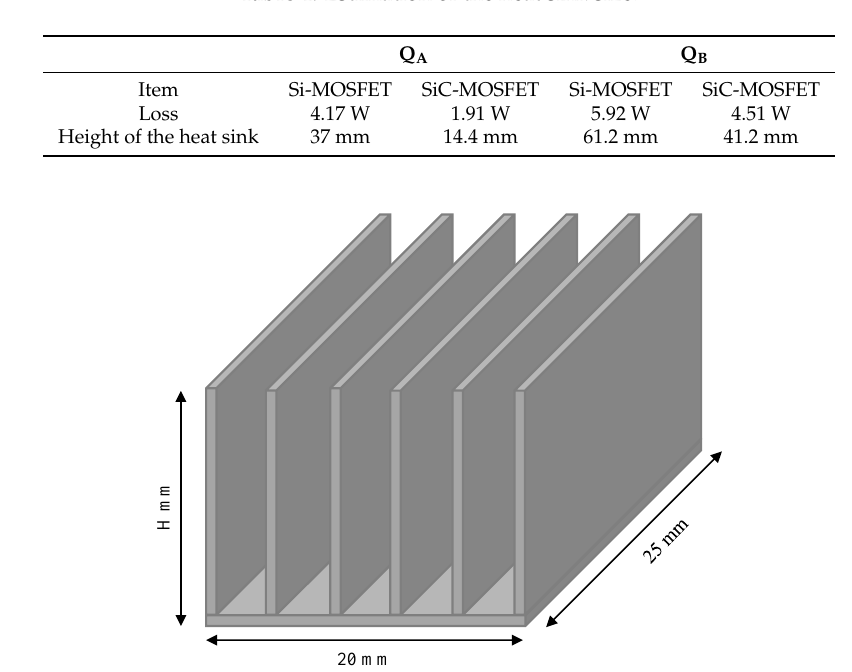
Table 4. Estimation of the heat sink size.